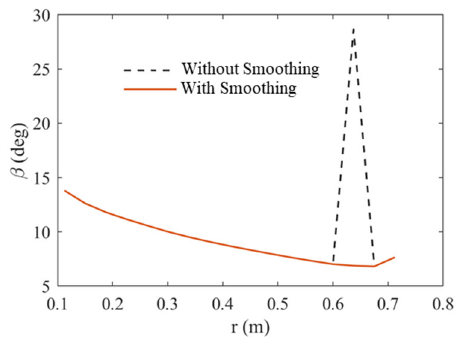
Figure 3. Smoothing modification to ensure first-order continuity.